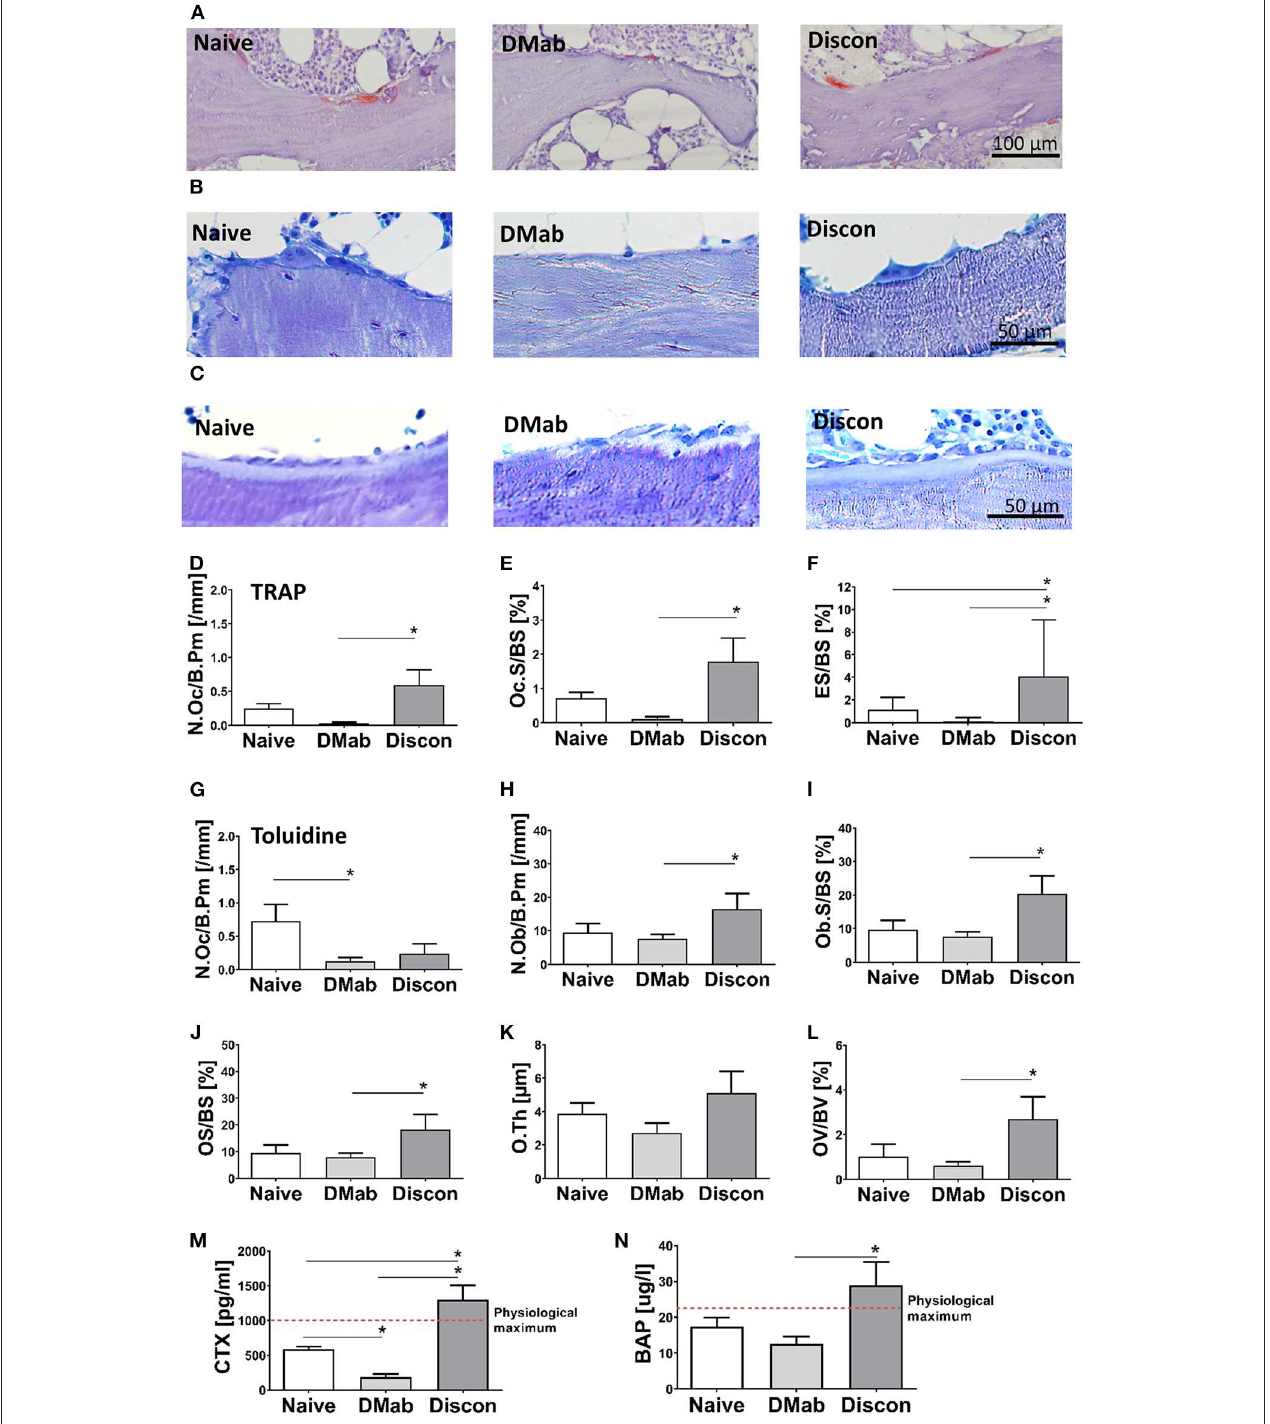
FIGURE 3 | Histomorphometry and serum measurements of bone turnover markers. Osteoclast and bone resorption parameters, as well as osteoblast and bone formation parameters, were assessed in the trabecular bone compartment via static bone histomorphometry. (A) Representative images of tartrate-resistant acid phosphatase (TRAP)-positive osteoclasts on trabecular bone surfaces, (B) toluidine blue staining showing osteoclasts, and (C) osteoblasts. (D–F) Quantification of osteoclast numbers per bone perimeter (N.Oc/B.Pm), osteoclast surface per bone surface (Oc.S/BS), and eroded surface per bone surface in TRAP staining. (G) Quantification of osteoclast number per bone perimeter (N.Oc/B.Pm) on toluidine blue staining. (H–L) Quantification of osteoblasts per bone perimeter (N.Ob/B.Pm), osteoblast surface per bone surface (OB.S/BS), osteoid surface per bone surface (OS/BS), osteoid thickness (O.Th.), and osteoid volume per bone volume (OS/BV). Quantification of bone turnover serum markers (M) C-terminal telopeptide of type I collagen (CTX), and (N) bone-specific alkaline phosphatase (BAP). Graphs show mean and SEM. Statistical analyses were performed using one-way ANOVA and Tukey post hoc test. * p < 0.05.